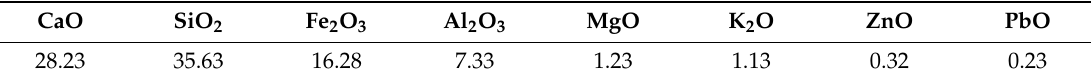
Table 2. Chemical composition of lead–zinc tailing (LZT) (wt%).